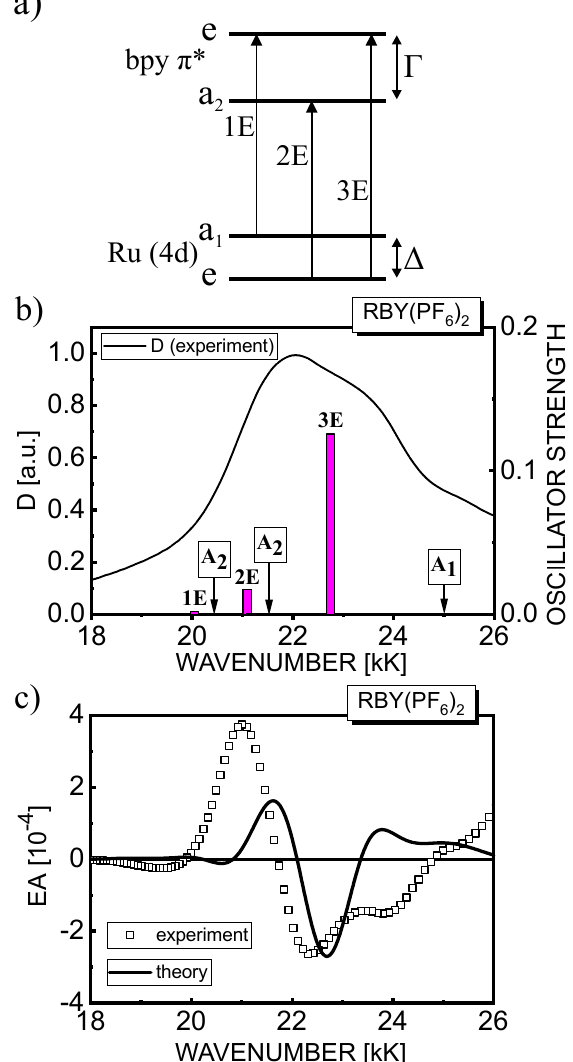
Figure 8. ( a ) Simplified diagram of single − electron energy levels for RBY complex in D 3 symmetry (based on [44, 60]). The splitting between the levels of the filled 4d Ru orbitals is denoted by Δ , and that between the levels of the empty ligand π * orbitals is denoted by Γ . The three doubly − degenerate MLCT transitions (1E, 2E, and 3E) are also indicated; ( b ) Stick − bar spectrum of the calculated oscillator strengths using the TDDFT method for RBY(PF 6 ) 2 in a vacuum superimposed on the experimental absorption spectrum of the RBY(PF 6 ) 2 film; ( c ) The EA spectrum calculated using the TDDFT method (solid line) for all excited states presented in part ( b ) of the figure compared with the experimental EA spectrum of the film